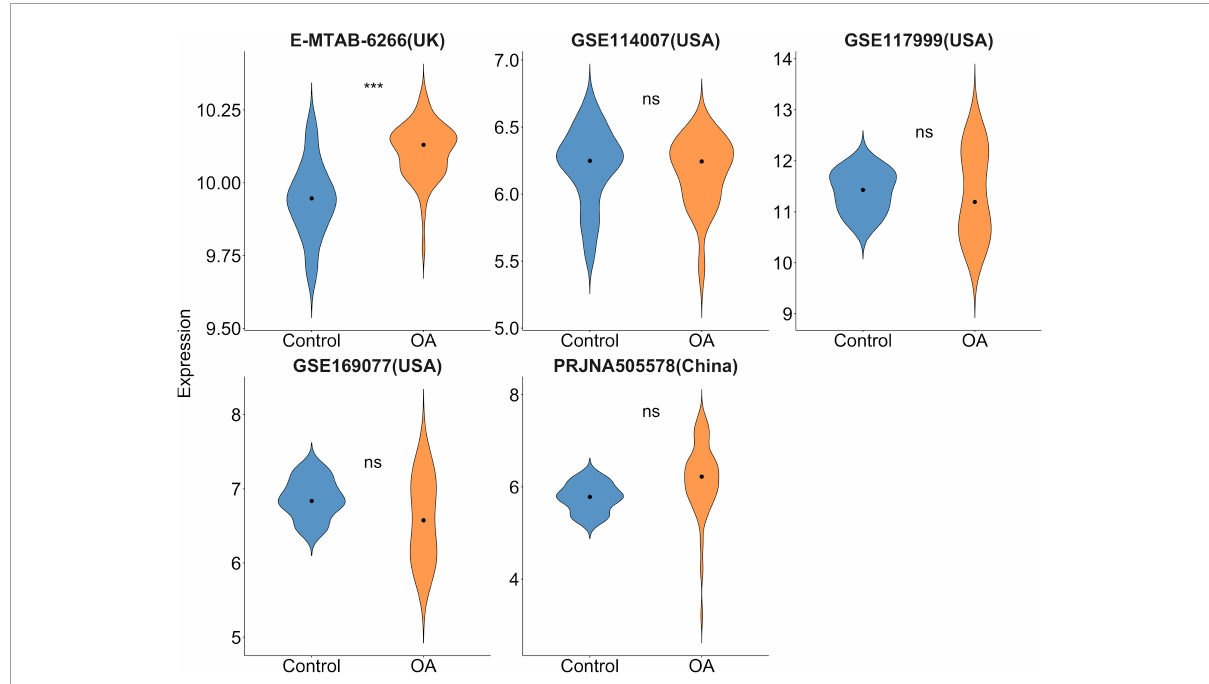
FIGURE1 Violin plot of FTO gene expression in microarray and RNA-sequencing data. Dots mean median. *** P <